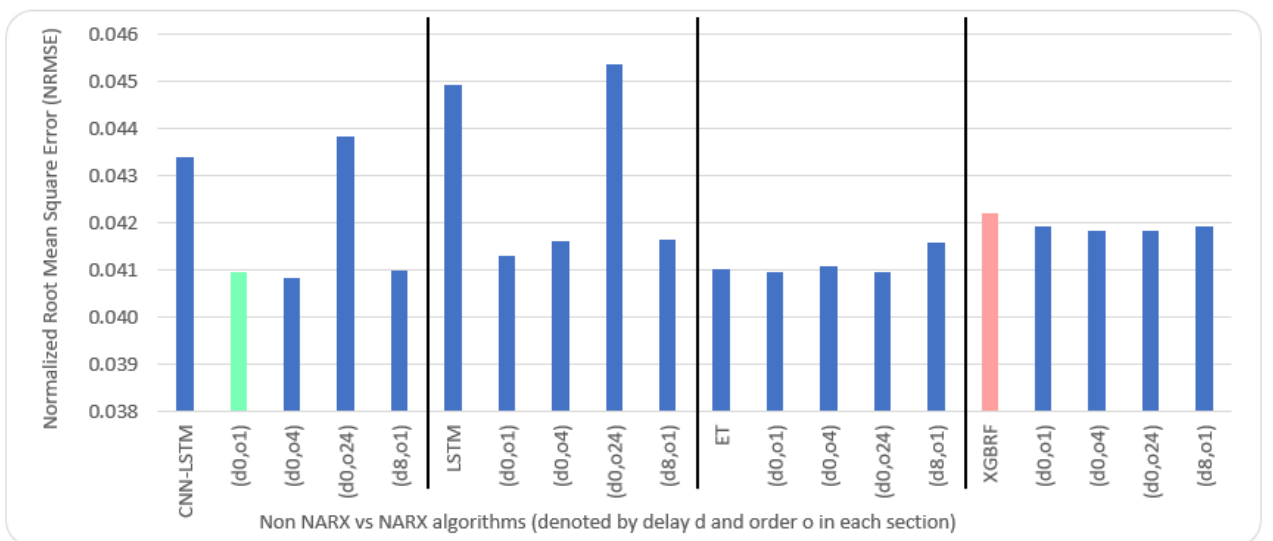
Figure 29. Evaluation results of non-NARX and NARX in terms of root mean square error for the Manchester dataset.